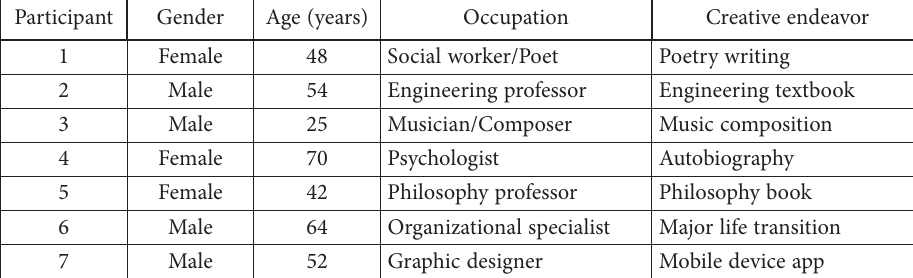
Table 1. Participant descriptions (source: created by